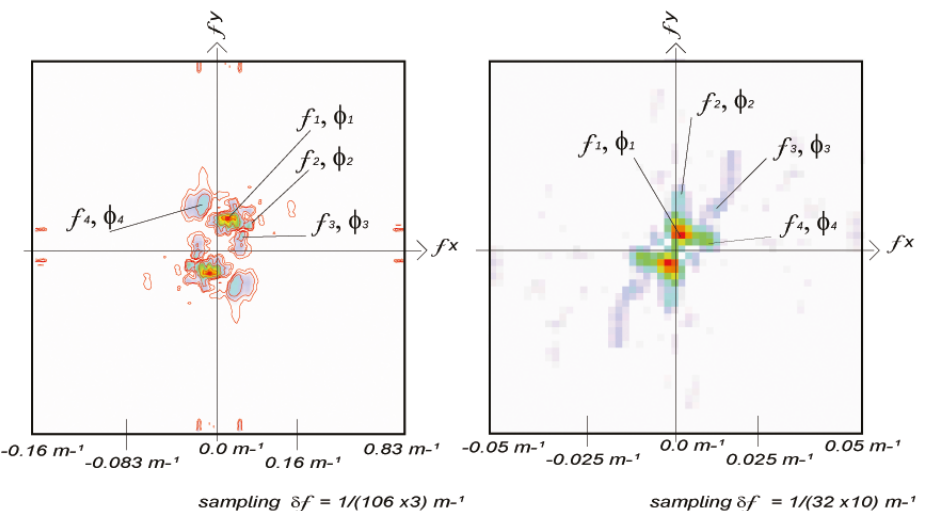
Figure 4. FFT spectra of the simulated waves ( left ) and Sentinel 2 waves ( right ). Size of the FFT window in this example: 106 pixels for the simulated waves and 32 pixels for Sentinel 2. ( c, λ ) couples are here represented as ( f, Φ ) couples; f is the FFT frequency—proportional to λ - and Φ is the FFT phase that we used to calculate c .